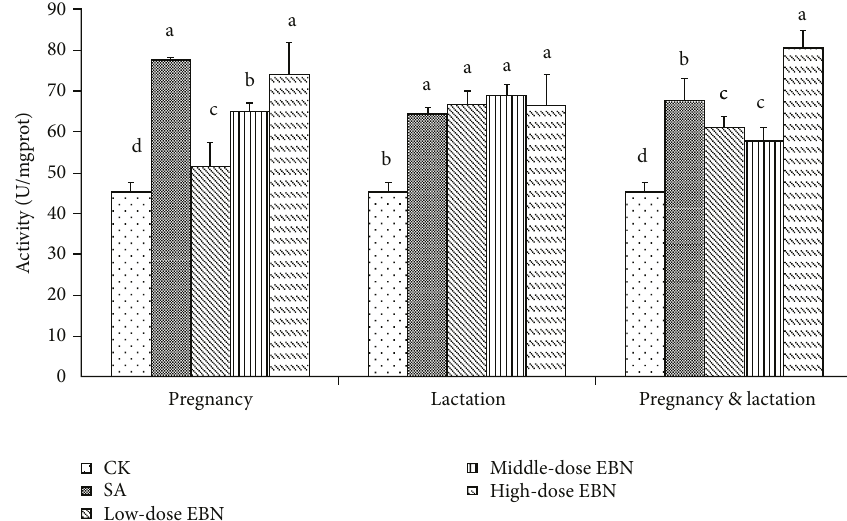
Figure 6: Comparison of superoxide dismutase (SOD) activity in brain tissue among the 10 weaning cubs from each group. Signi fi cant di ff erences were indicated by di ff erent letters for each group ( P < 0 05 ).